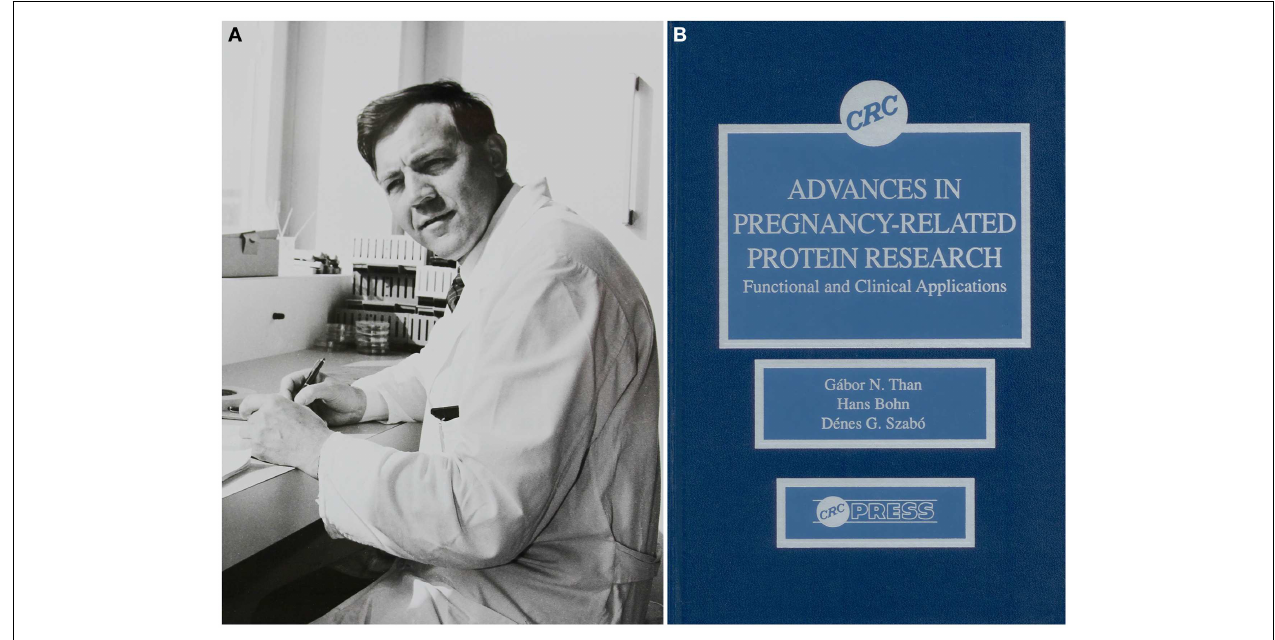
developed specific antisera and immunosassays for them between 1965 and 1989.The photo was obtained as a courtesy from Gabriele Bohn. (B) A book co-written by Hans Bohn, Gábor N.Than and Dénes G. Szabó published in the USA summarized the existing knowledge in the research field in